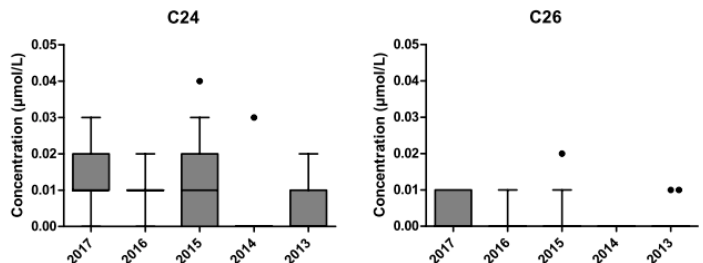
Figure 1. Changes in carnitine and acylcarnitine concentrations. The impact of metabolite instability upon long-term storage at room temperature. The boxplots represent the first quartile, median and third quartile. The whiskers extend to the 2.5th and 97.5th percentiles. Individual dots represent non-extreme outliers. Shaded areas represent the reference ranges as determined by our centre for the neonatal population. For C5:1-, C12OH-, C14OH-, C16OH-, and C18OH-, C6DC-, C16DC-, C18DC-, C24-, and C26-carnitine, the upper reference limit is below the detection limit (i.e., not detectable).